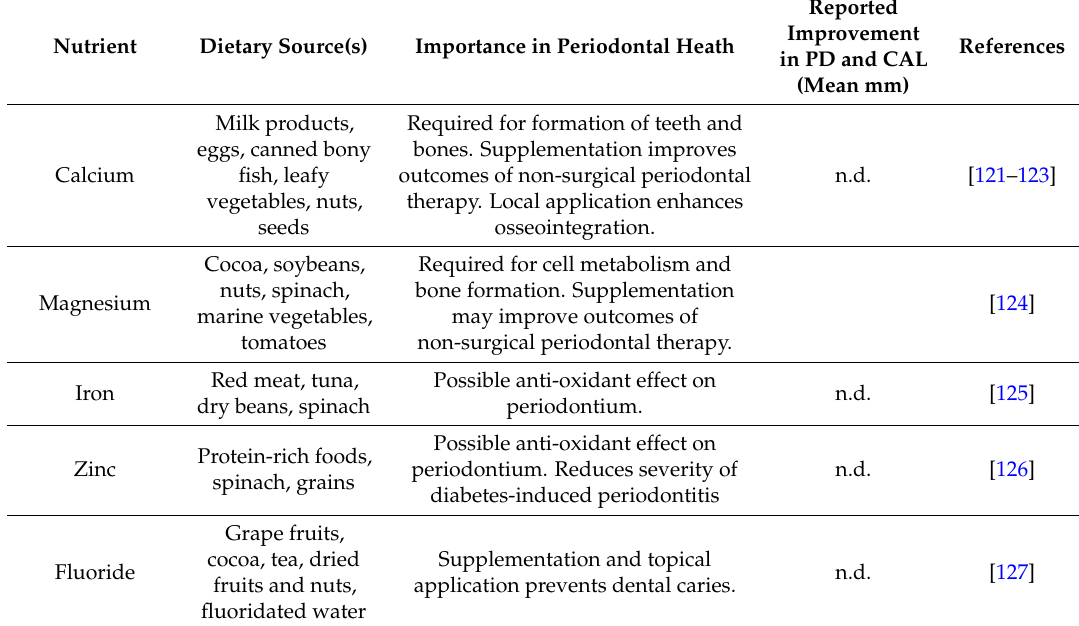
Table 2. Major minerals, their dietary sources, daily requirement, deficiencies, and reported importance in periodontal